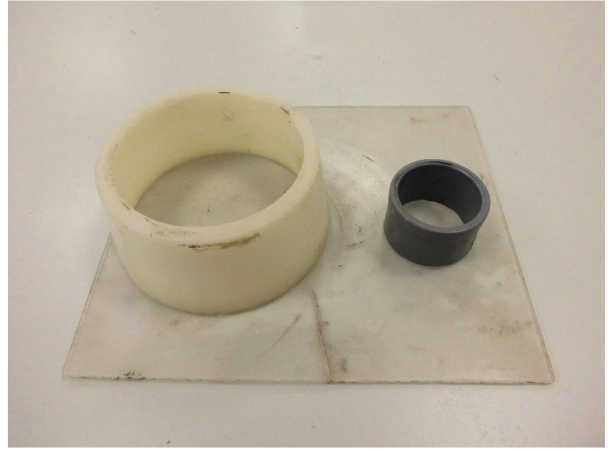
Figure 3. Dimensions of molds used to test workability.